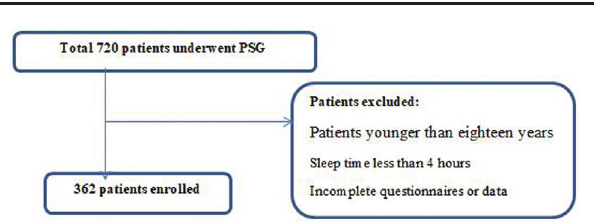
Flow chart of patients enrolled in the